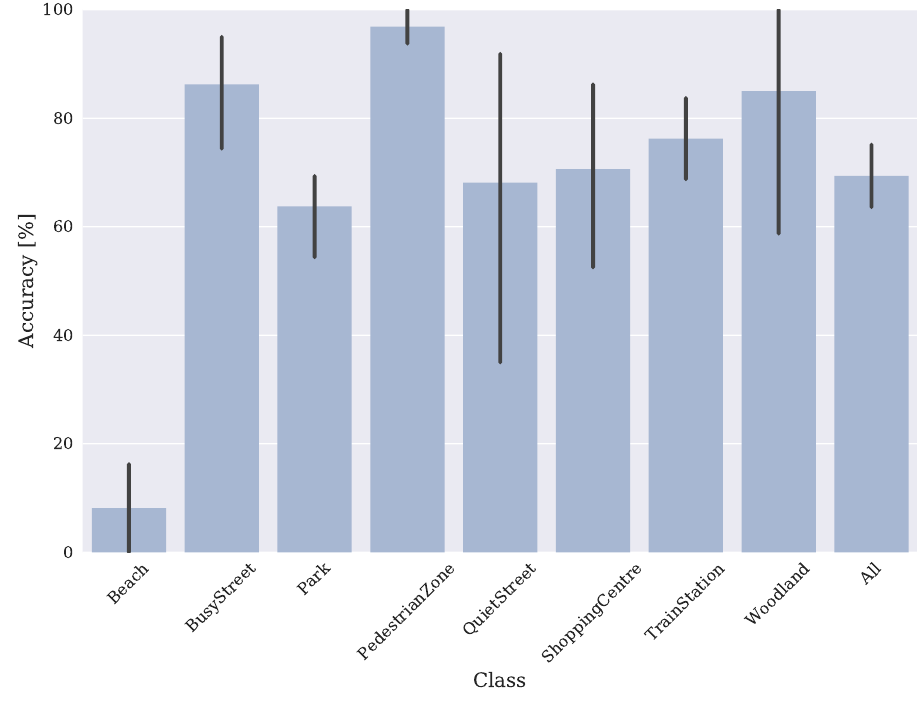
Figure 3. Mean and standard deviation classification accuracies across all folds for each scene class using the elevation/diffuseness–Gaussian mixture model (E/D-GMM) classifier.